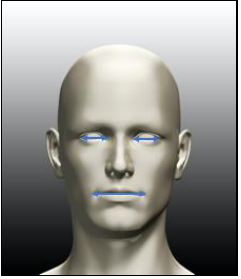
Figure 6. Vector distances in [16].